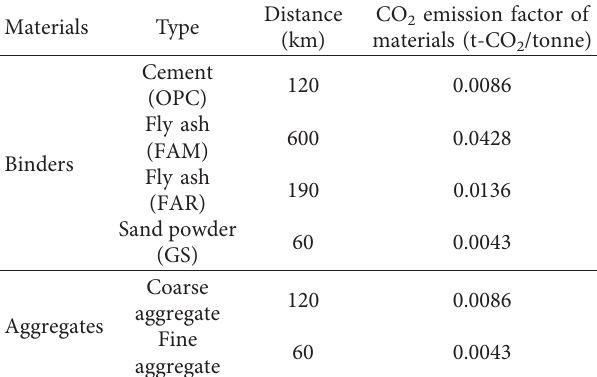
Table 5: Emission inventory data used for CO lations, for material transportation to the Bangkok metropolitan